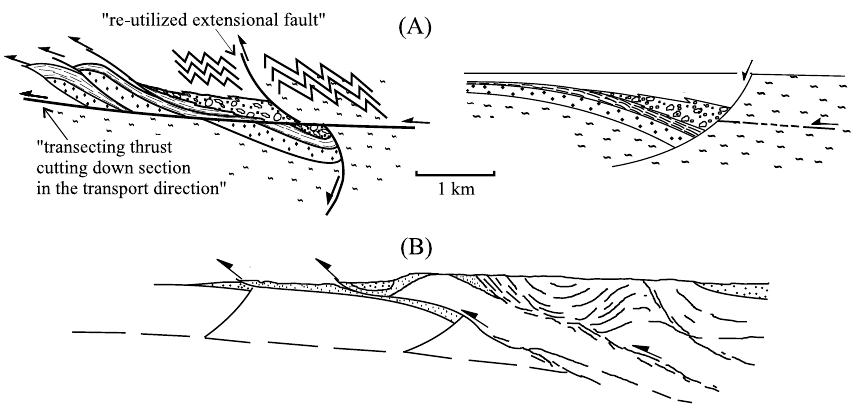
Fig. 11 – (A) The McCook half-graben of the Kechika Trough, Canada, a basin closed by the footwall of an extensional detachment (simplified from McClay et al. 1989). (B) An idealized representation of the west Alp basin, closed by the footwall of an extensional detachment (modified from Butler